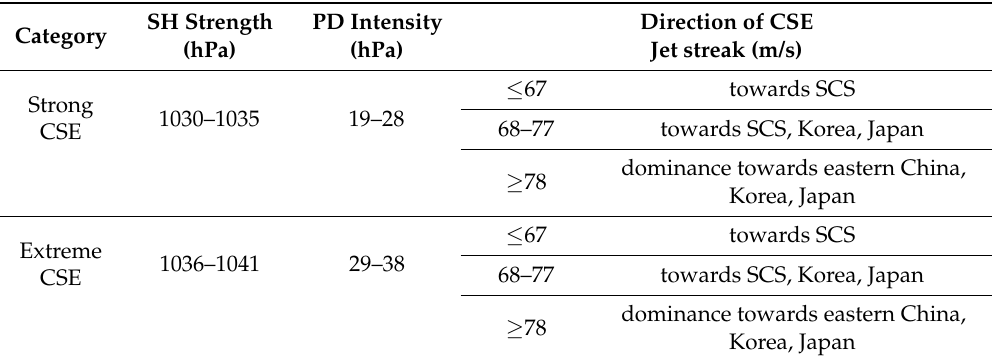
Table 1. The CSE-PD scale criteria for classifying cold surge events (CSEs) and their progression based on monthly averaged PD (hPa) and jet streak (m/s) from 1979 to 2016. SCS: South China Sea.